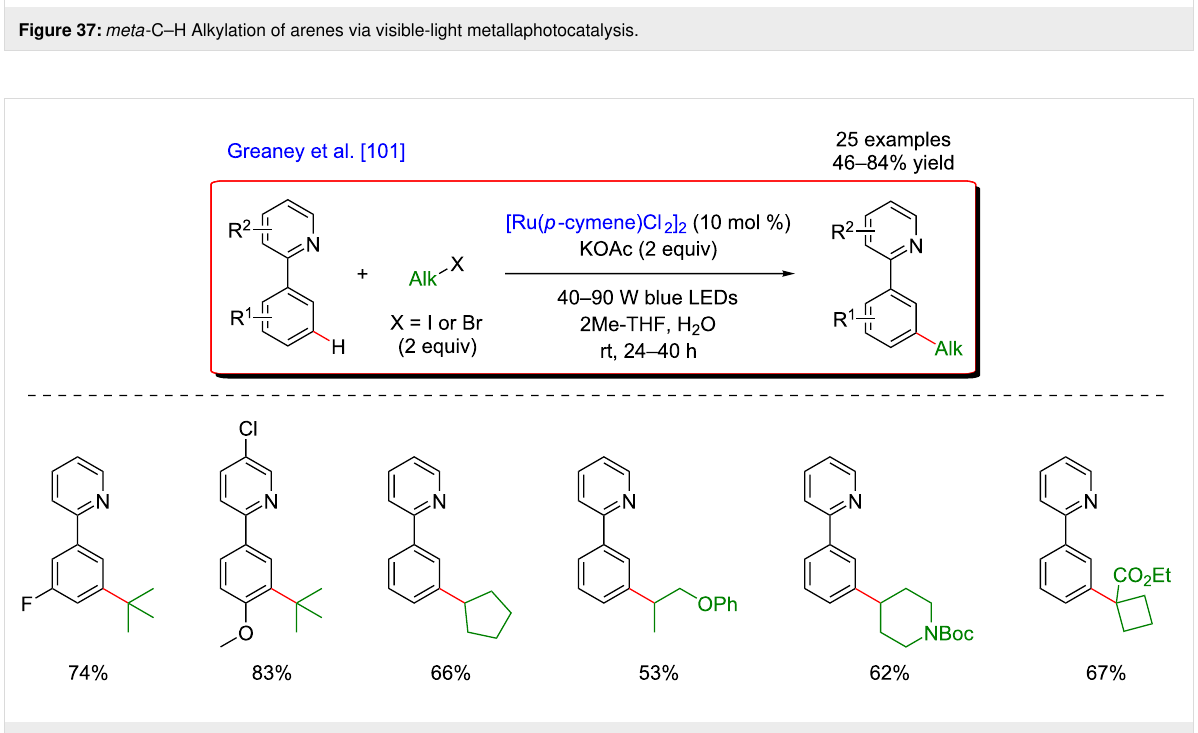
Figure 38: Alternative procedure for meta -C–H alkylation of arenes via metallaphotocatalysis.